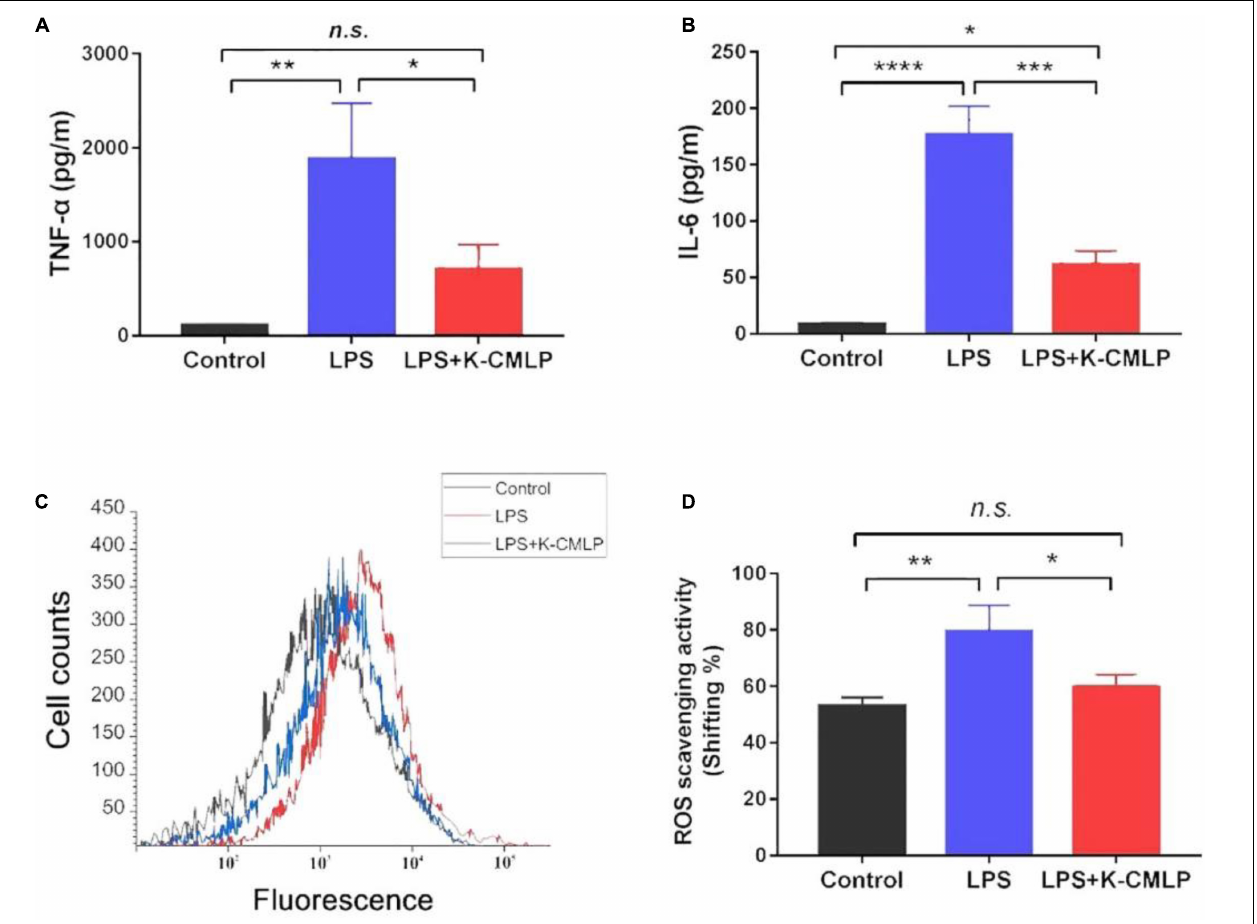
FIGURE 9 | Anti-inflammation effect of K-CMLP on production of pro-inflammatory cytokines [TNF- α (A) , IL-6 (B) ], cell counts (C) and reactive oxygen species (ROS) scavenging activity (D) in LPS induced RAW 264.7 cells model. Values represent the mean ± SE (bars) from eight independent samples ( n = 3). * Means P < 0.05, ** means P < 0.05, *** P < 0.0005, and **** P < 0.0001 compared with the only LPS treated group for incubating 24